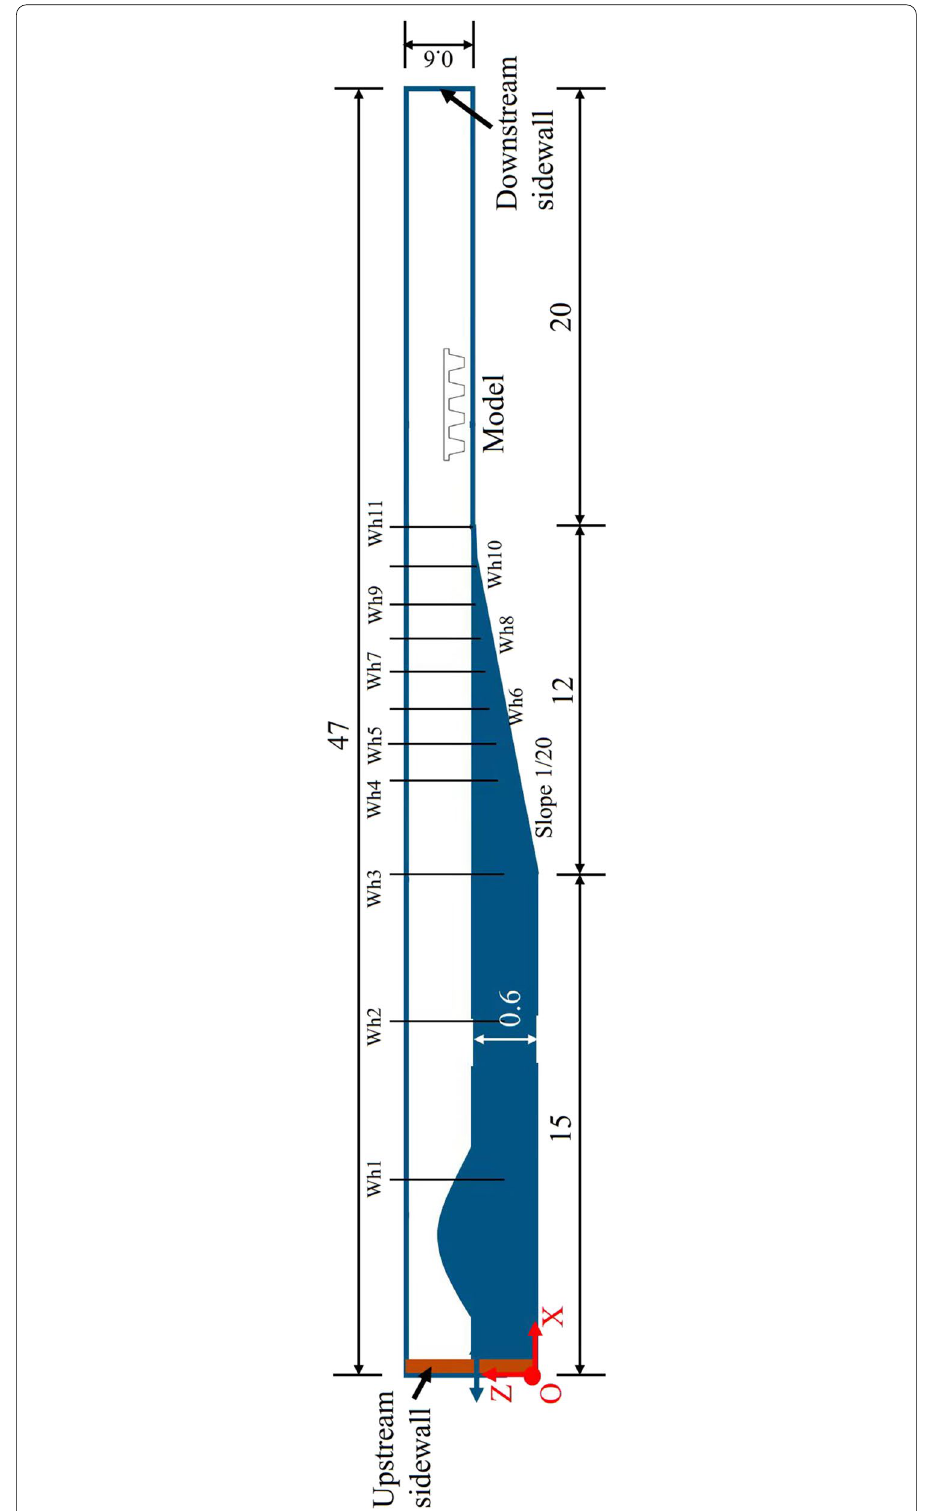
Fig. 1 Front view of the numerical wave flume (unit: